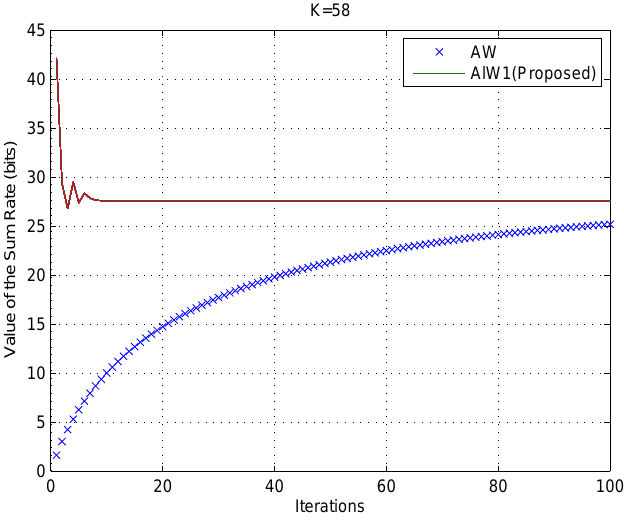
Figure 8. Algorithm ALW1 compared with Algorithm AW, as K = 58.